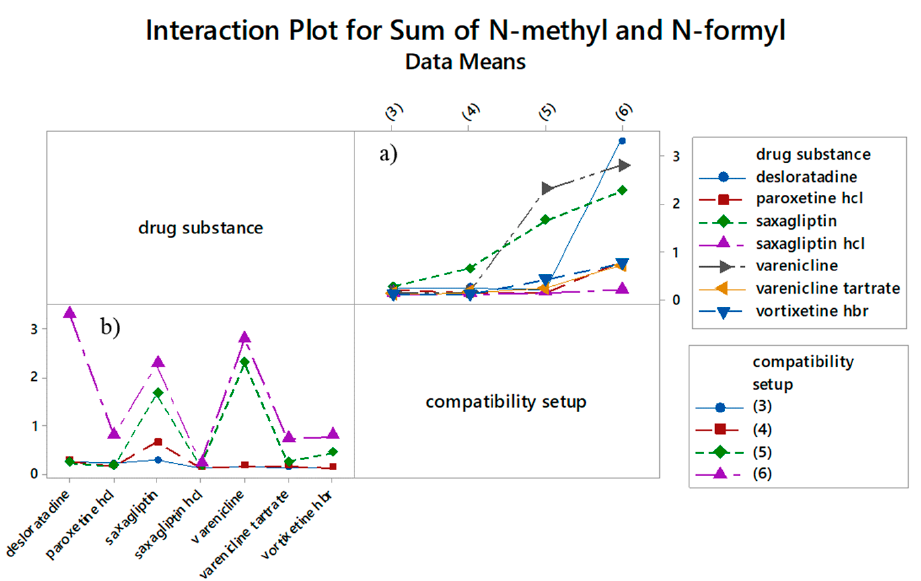
Figure 6. Interaction plot for sum of N -methyl and N -formyl impurities for different drug substances and compatibility setups. Data presented with ‘compatibility setup’ on x axis ( a ) and ‘drug substance’ on x axis ( b ).